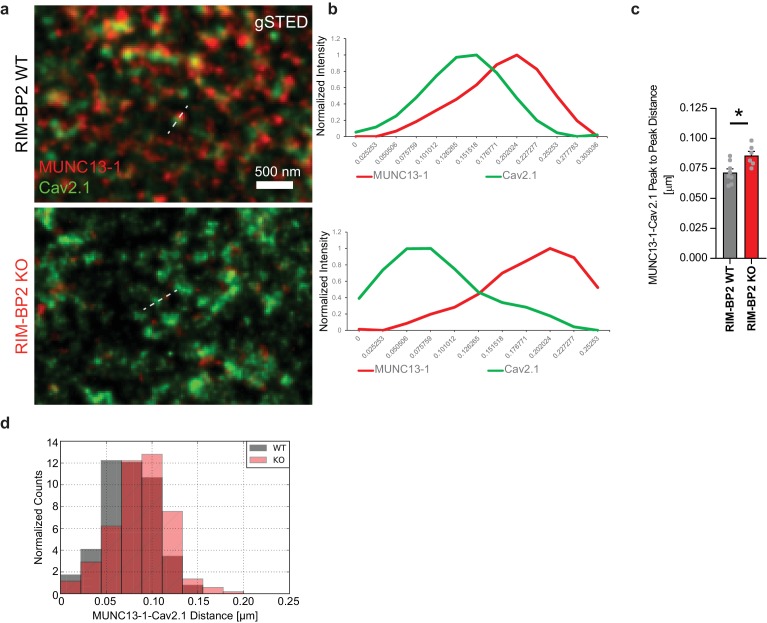
Loss of RIM-BP2 leads to an increased distance between Munc13-1 and Cav2.1 clusters at MF synapses.(a) in situ gSTED images of Munc13-1 and Cav2.1 at MF synapses in RIM-BP2 WT and KO mice. Dotted line represents an example of a synapse analyzed by line profile measurement. Line profile thickness was set to ~250 nm. (b) Intensity line profiles of the synapses displayed in (a). For display, intensity in each channel was normalized to its maximum after background subtraction. We analyzed 30–48 line profiles per mouse (n (WT) = 8 mice and n (KO) = 6 mice). (c) Munc13-1-Cav2.1 distances averaged per mouse analyzed. A significant increase in the distance at which Munc3-1 clusters are found relative to Cav2.1 clusters was observed in RIM-BP2 KO as compared to WT mice. (d) Frequency histogram for all Munc13-1-Cav2.1 distances found. Counts were normalized to obtain a probability density function with an integral equal 1. Values represent mean ± SEM. *p<0.05. For statistics please see Figure 3—figure supplement 1—source data 1.10.7554/eLife.43243.010Figure 3—figure supplement 1—source data 1.Statistics of data presented in Figure 3—figure supplement 1.